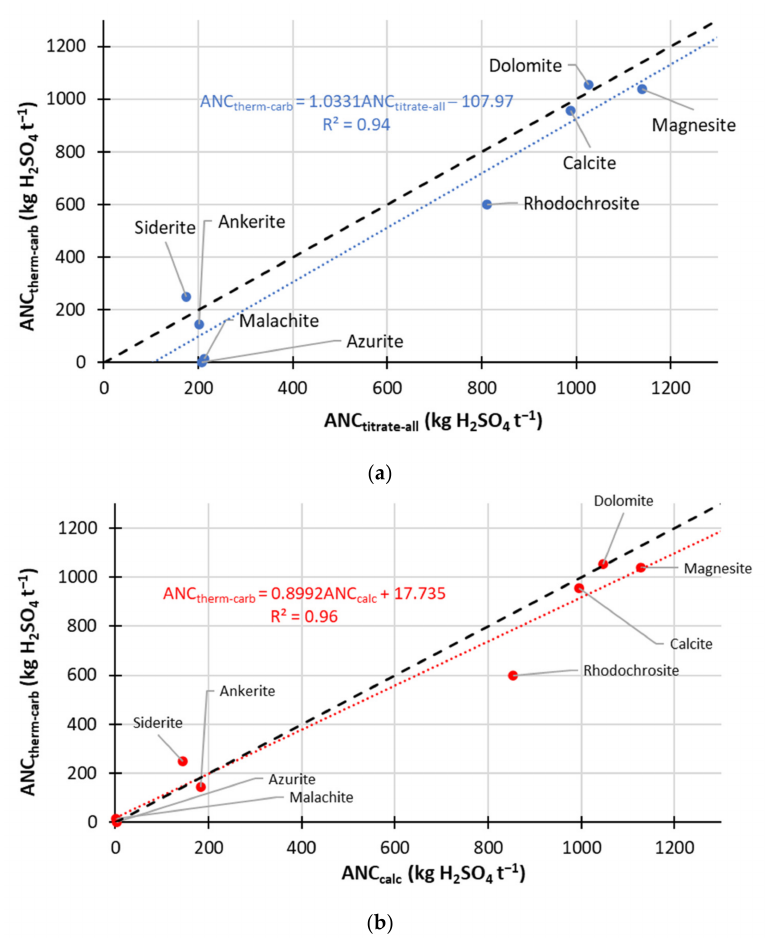
Figure 4. ( a ) Correlation of ANC therm-carb and ANC titrate-all (ANC methodology (1)). ( b ) Correlation of ANC therm-carb- and ANC calc calculated from bulk assay concentrations for Mg, K, Na, Ca, and Mn. The dark dotted line indicates the ratio of